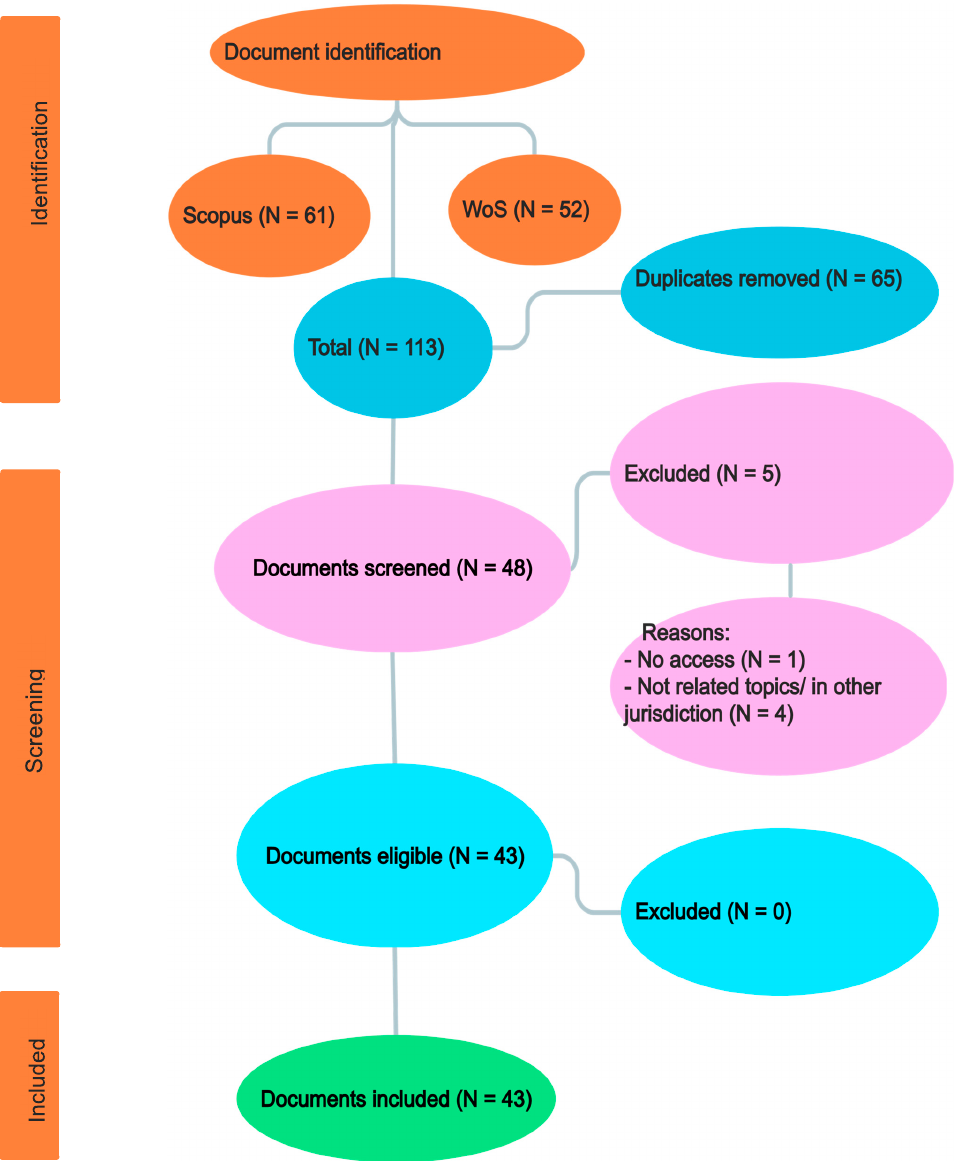
Figure 2. Search and selection process for documents used in the review. Note: N denotes the number of documents.